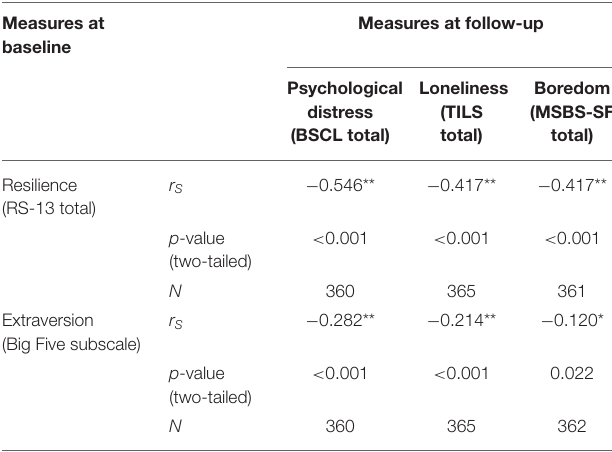
TABLE 2 | Association of resilience and extraversion at baseline with psychological outcome measures at follow-up (Spearman rank correlation